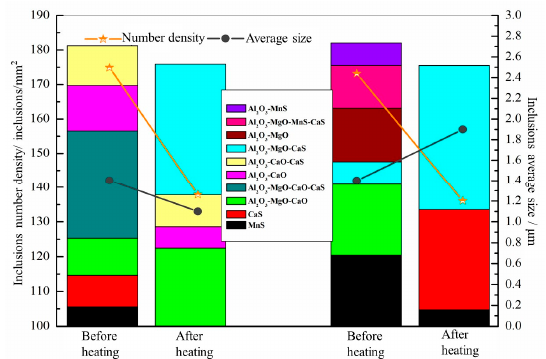
Figure 6. Changes in the number density, size and type of inclusions before and after heating.